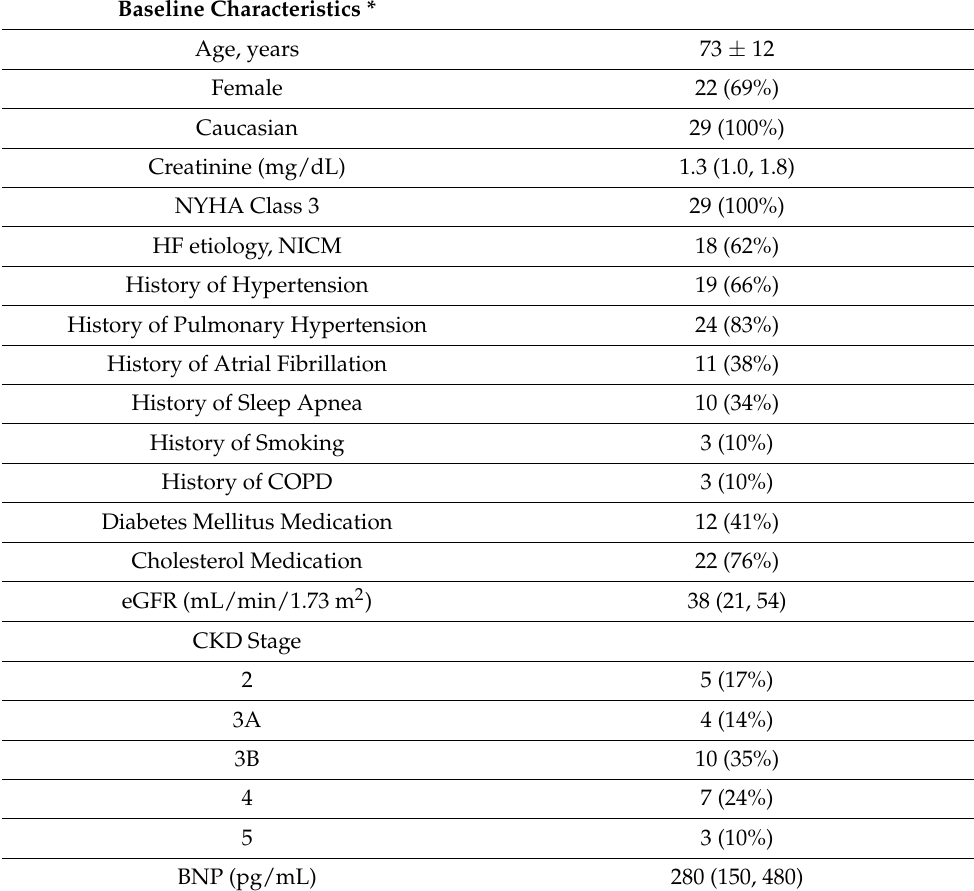
Table 1. Baseline characteristics.